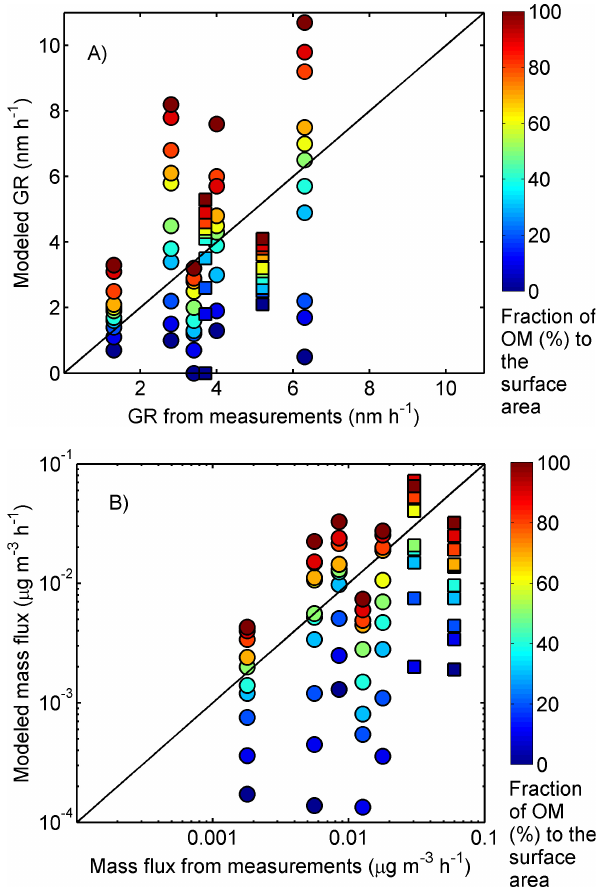
Fig. 7. Particle growth rates (A) and mass fluxes (B) as determined from the measurement data and the model simulations for 7 parti- cle formation event days in Hyyti¨al¨a and Egbert (see Table 2). The color scale depicts the fraction of total OA mass flux that was dis- tributed on aerosol surface area in each of the simulations.